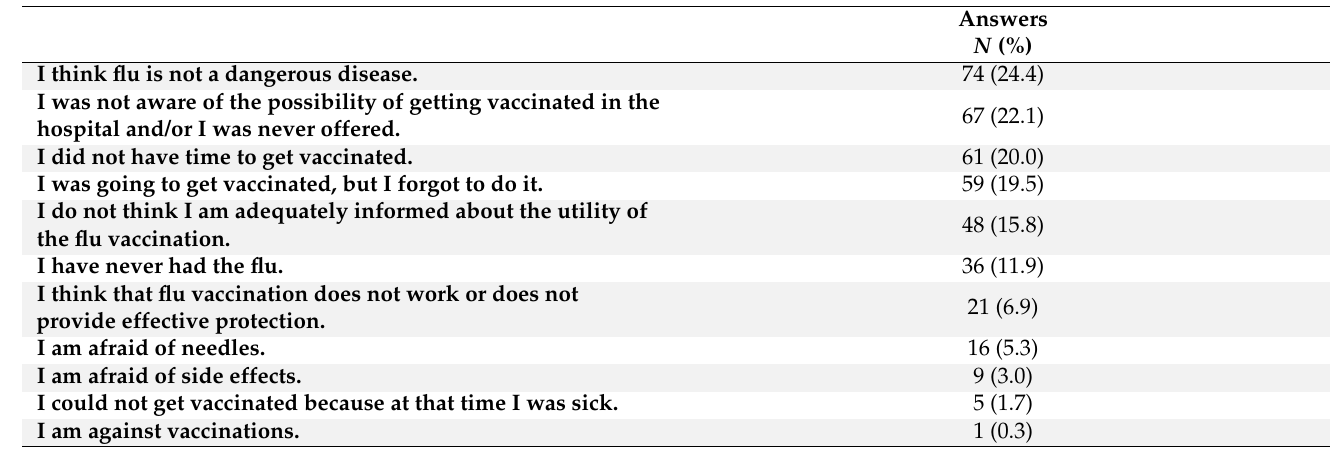
Table 3. Reasons for refusing flu vaccination ( n = 304).